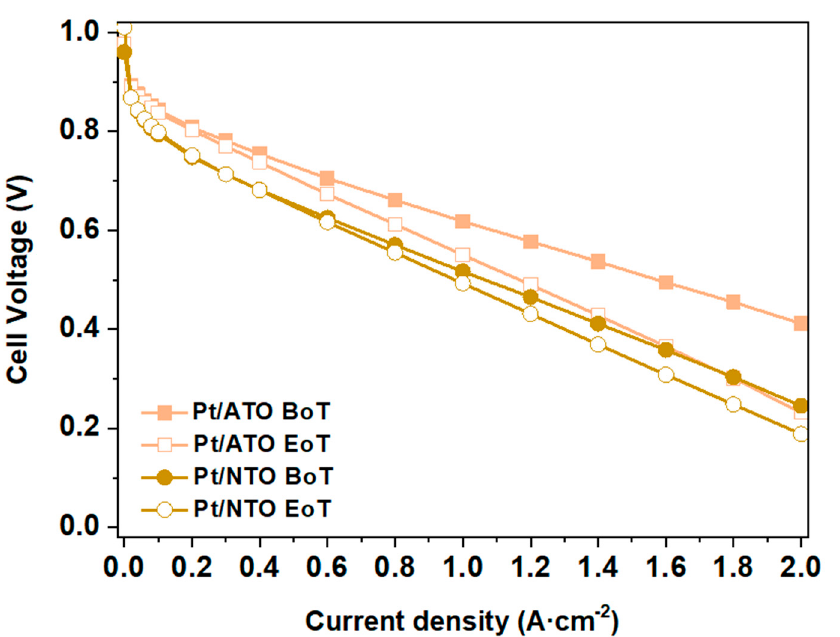
Figure 1. Polarization curves of membrane electrode assemblies including cathodes with Pt / ATO and Pt / NTO (0.35 mg Pt cm − 2 ) recorded under H 2 / O 2 (stoichiometry 1.5 / 2.2 bar absolute pressure) at T = 80 ◦ C and 100% RH before (BoT) and after 35 AST cycles (EoT).